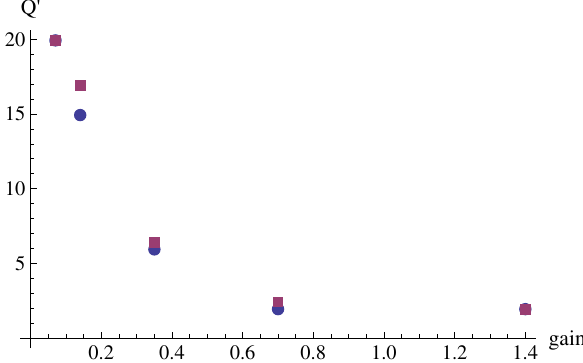
FIG. 2. Threshold chromaticity Q 0 versus the damper gain for BeamBeam3D tracking (circles) [17] and NHT solutions (squares)